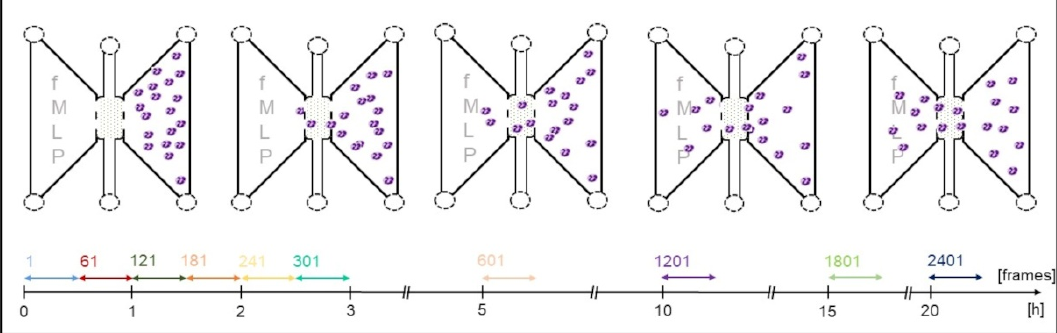
Table 1. Composition of the 3D-µ-Slide’s compartments. More detailed information about the com- ponents can be found in Table A1 in the Appendix.